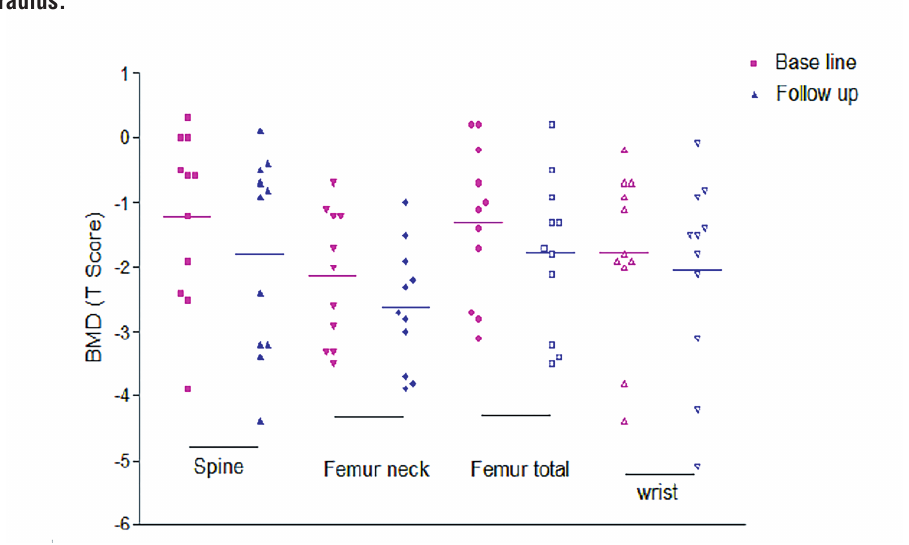
Figure 3 - Baseline and Follow-up BMD (T-Score) in patients on ADT without Zoledronic acid therapy showing worsening at all site except radius.